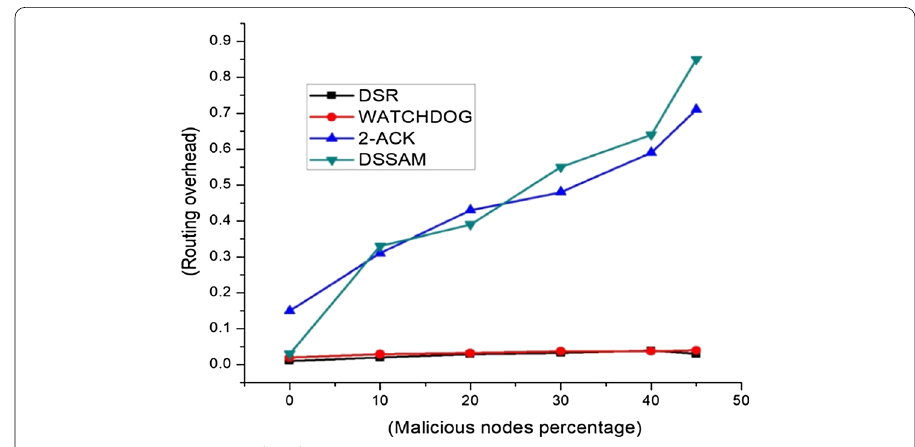
Fig. 15 Case 2-Routing Overhead